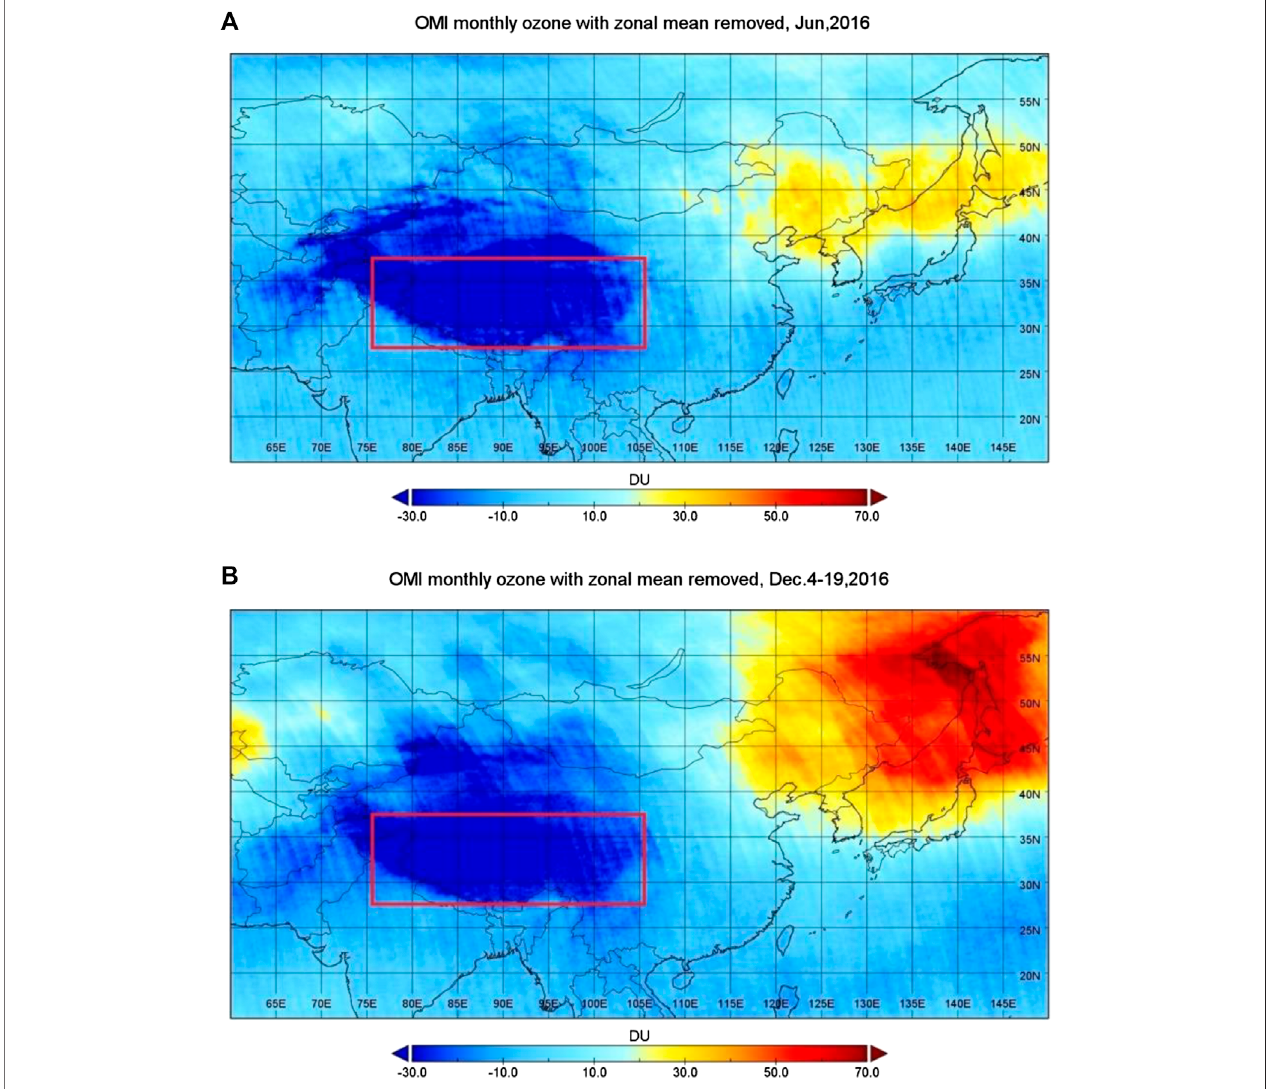
FIGURE 1 | Spatial distribution of the ozone de fi cit over east Asia (A) in June 2016 and (B) in December 2016 (using data during 14 – 19 only). Data are from OMI measurement.